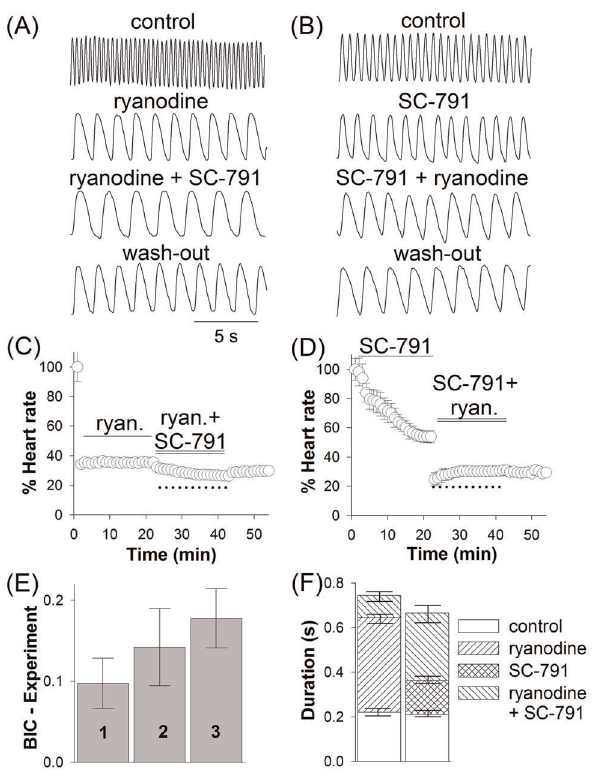
Figure 5. Effects of ryanodine on heartbeat. Typical examples of heartbeat in control, after 20 min application of either 100 m M ryanodine ( A ) or 30 m M SC-791 ( B ) alone followed by 20 min exposure to a solution containing both 100 m M ryanodine and 30 m M SC-791, and after the wash-out. ( C, D ) Time course of the average heart rate in the experiments described in the panels ( A ) and ( B ), respectively; dotted lines indicate the value of BIC (82% heart rate inhibition) (see Results); panels ( C ) and ( D ), averages of 7 and 6 experiments, respectively. ( E ) Bar plot illustrates differences between the BIC of 0.82 and the experimentally determined total fractional reduction in heart rate for three experimental conditions: when SC-791/ryanodine was applied after (1) exposure to ryanodine alone, (2) exposure to SC-791 alone, and (3) without pre-exposure of the preparation to any compound. ( F ) Bar plot summarizes effects of ryanodine and SC-791 on the duration of heart contraction when the chemicals were applied in different order as in the panels ( A ) and ( B